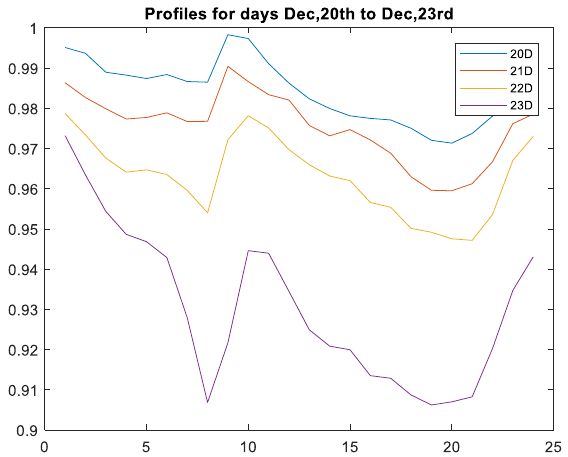
Figure 15. Coefficient profiles for the modifying variables of 20–23 Dec. Each day closer to Christmas day lowers the demand.